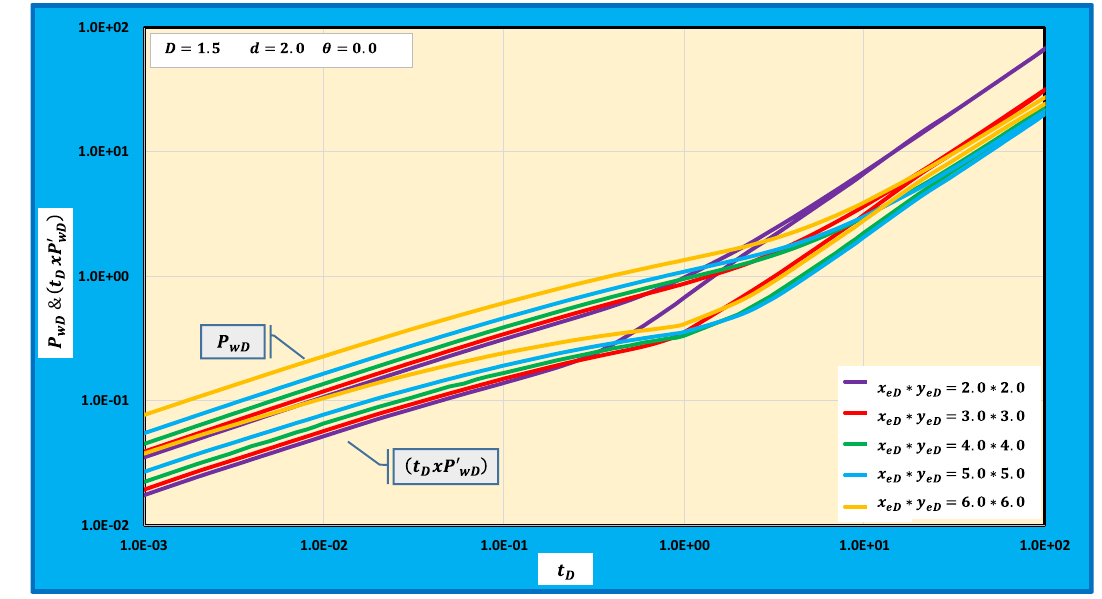
Fig. 9 Wellbore pressure and pressure derivative of different drainage areas